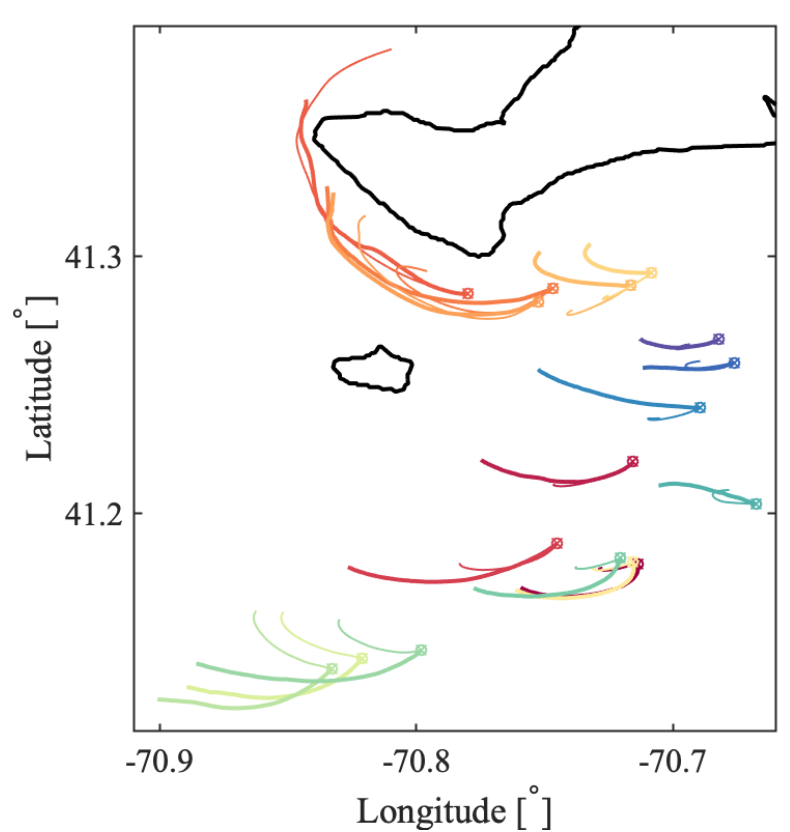
Figure A13. Comparison between real and simulated drifter trajectories for the 2018 No Man’s Land experiment between 04:00 and 10:00 UTC. The trajectories of CODE drifters are plotted with thick lines. The corresponding numerical trajectories, simulated with the same initial conditions as their corresponding CODE drifter, are plotted with thin